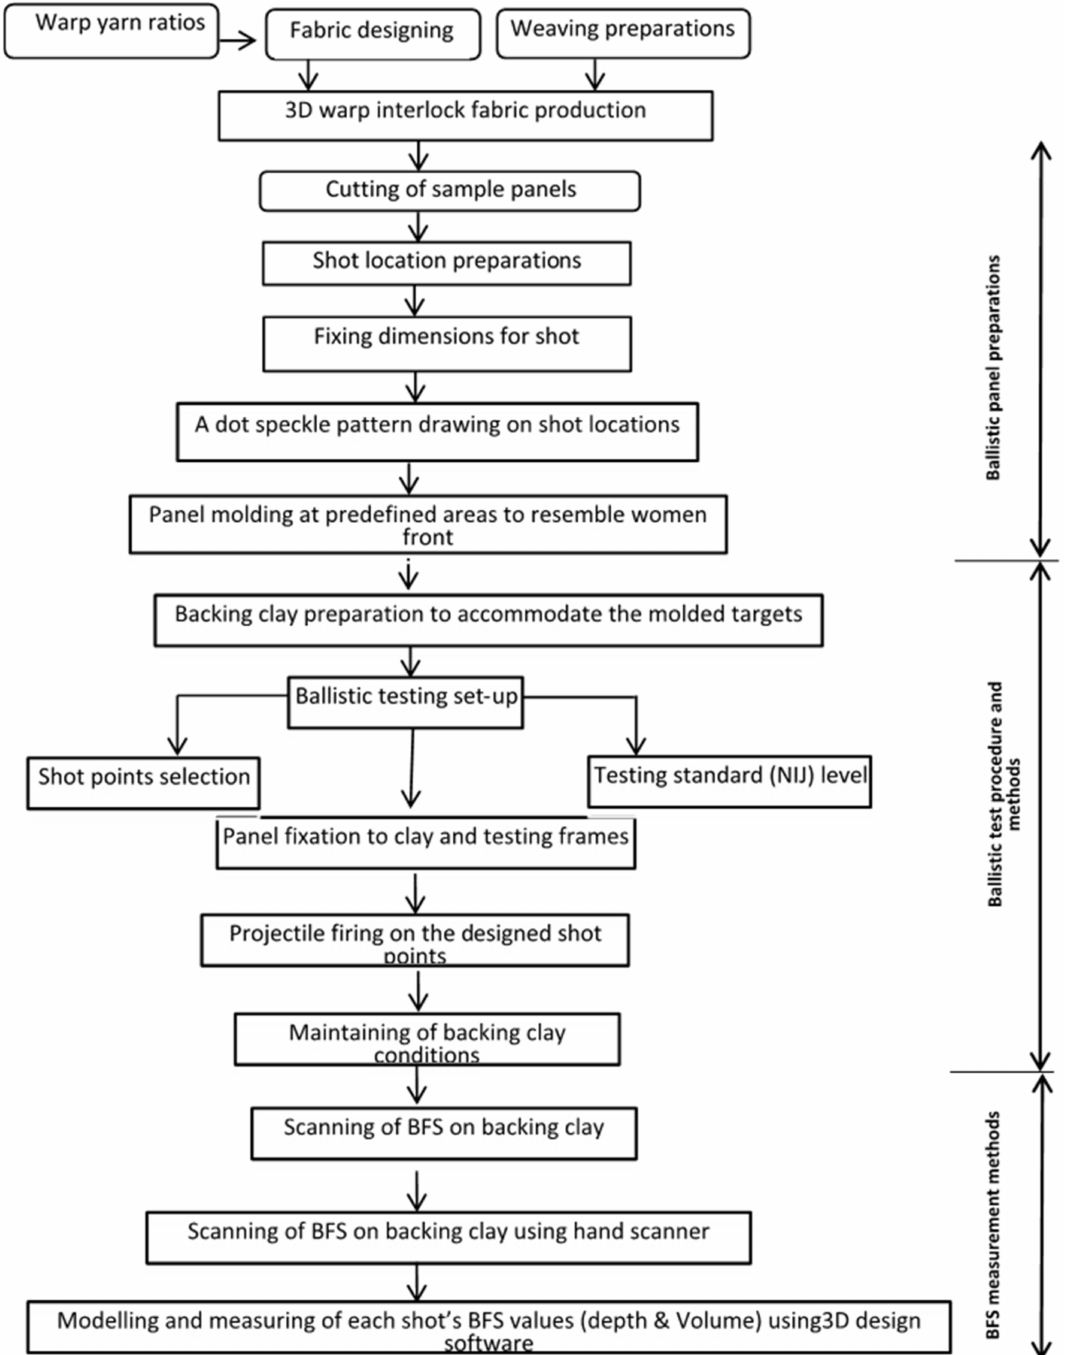
Figure 3. Schematic views of sample preparation, the testing protocol and BFS measurements